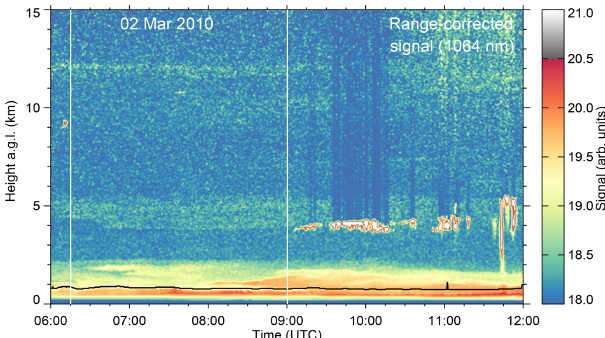
Figure 2. Height–time display of the range-corrected signal ob- served at 1064nm with the Polly XT lidar on 2 March 2010. The analysed period between 06:15 and 09:00UTC is framed in white. The planetary boundary layer top height is indicated by the black